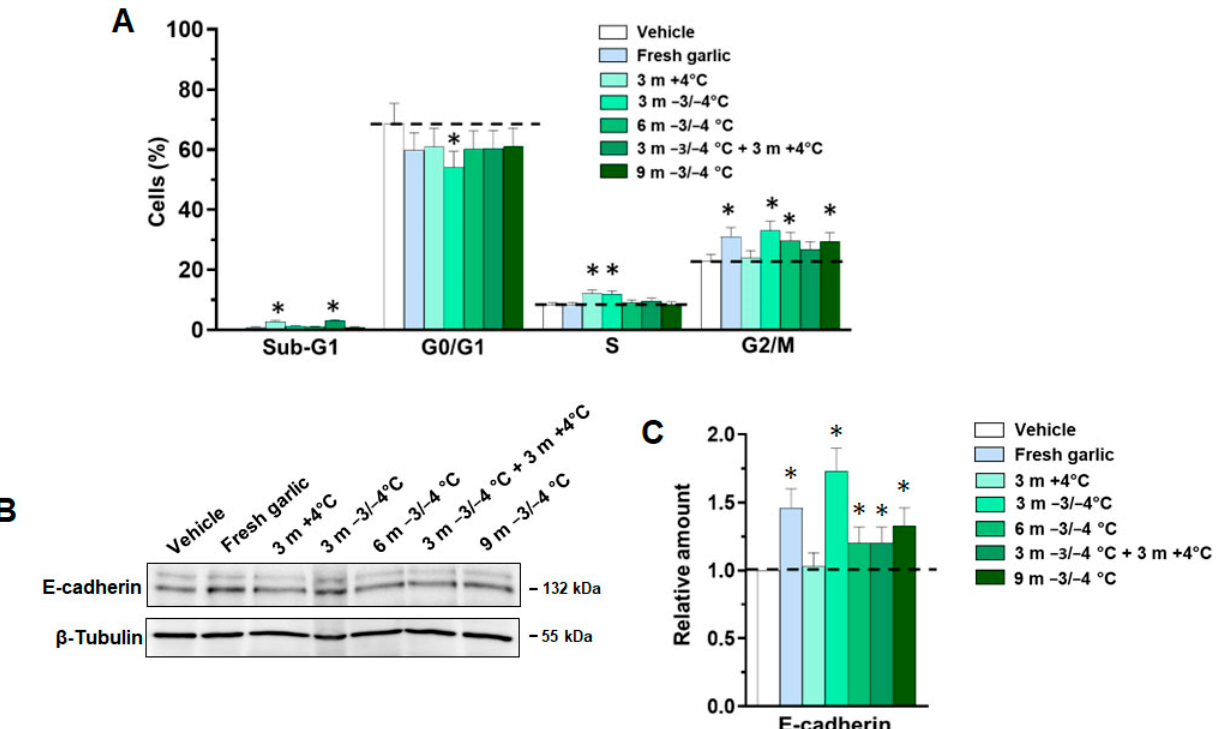
Figure 3. Anti-tumoral effects of VGE from garlic under different storage conditions on breast cancer-derived cells. In ( A ), the cell cycle distribution of MCF7 cells grown for 72h in control conditions (Vehicle) or the presence of 1:800 VGE from garlic conserved at the indicated storage conditions. * p < 0.05 with respect to Vehicle. In ( B ), representative immunoblot analysis was performed with the indicated antibodies of lysates from MCF7 cells cultured, as indicated above. In ( C ), histograms, as deduced from the analysis of chemiluminescence signals, reported the levels of E ‐ cadherin normal ‐ ized to β‐ Tubulin, used as an internal control for equivalence of loaded proteins. * p < 0.05 with respect to control conditions taken as 1. Dotted lines indicate the values of the control conditions (vehicle). All data are the mean of three separate experiments ± SD.